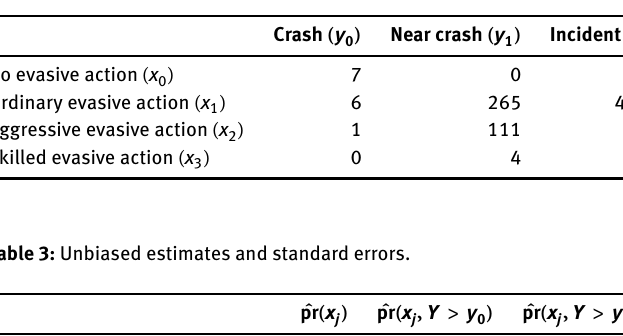
Table 2: Drivers of the following vehicles: multiple evasive actions.